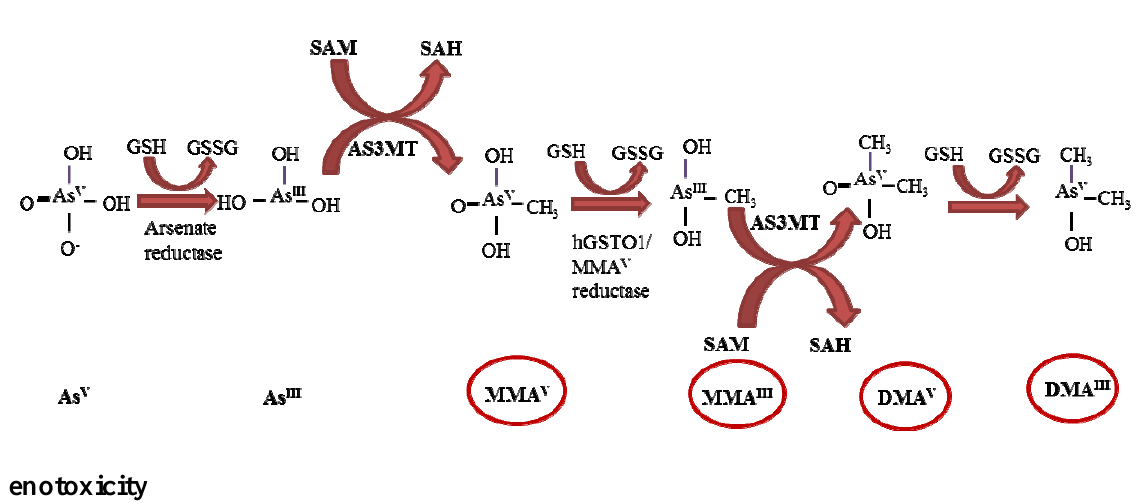
Figure 1. The metabolism pathway of inorganic arsenic showing arsenate reduction to arsenite and methylation to pentavalent and trivalent